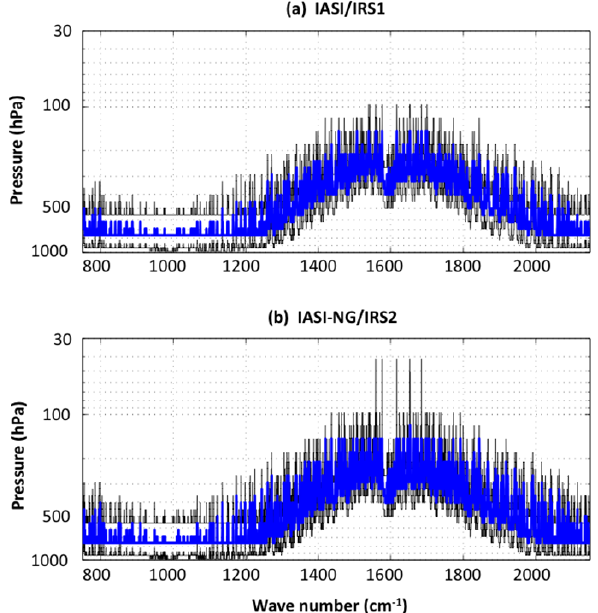
Figure 6. Pressure of the maximum (blue line) and of the half- height width (black) of the H 2 O Jacobians at the IASI spectral reso- lution (upper panel) and at the IASI-NG spectral resolution (bottom panel). Average over the TIGR tropical atmospheric situations.